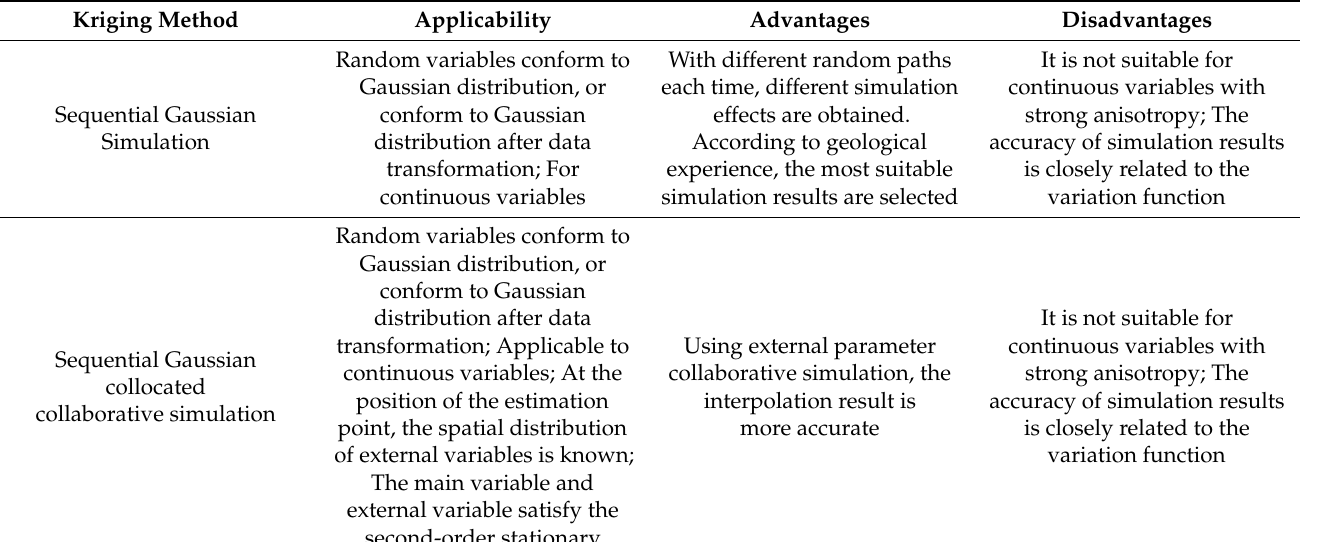
Table 2. Comparison of different sequential Gaussian simulation